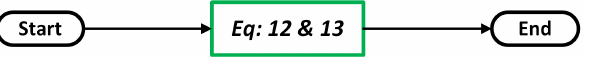
Figure 11. Case VI flow